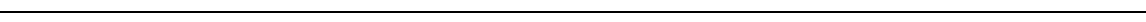
Fig. 4 Apical actin nucleated by formins contributes to centriole stability in mature ependymal cells. a Mature (P15) ependymal cell centrioles (labelled with FOP or Cep164; red) and formins (green and grey); note that all formins colocalise with the centriolar patch (red dashed lines); cell borders are outlined with dashed white lines. b – d Lateral wall explants from P15 mice treated for 12 h with DMSO or SMIFH2. b F-actin (phalloidin, grey) and centrioles (FOP, red) in mature ependymal cells from DMSO- or SMIFH2-treated explants. Cell borders and centriolar patches are outlined with dashed white and red lines, respectively. In control (DMSO-treated) explants, apical actin is enriched in the centriolar patch; formin inhibition prevents enrichment. Subapical actin staining is slightly affected by SMIFH2-treatment. c , d Ratio between mean phalloidin fl uorescence intensities in the centriolar patch (red dashed lines) and in the remaining cell surface (white minus red dashed lines) at the apical ( c ) and subapical ( d ) levels. Error bars represent the sem of: at the apical level, n = 96 cells for DMSO- and SMIFH2-treated explants; at the subapical level, n = 56 and 82 cells for DMSO- and SMIFH2-treated explants, respectively, from three independent experiments. P -values were determined by the Mann – Whitney test; * P = 0.0156; *** P ≤ 0.0001. Scale bars = 5 μ m. e Representative kymographs (200 ms) of motile cilia in P15 brain slices treated for 12 h with DMSO or SMIFH2 (formin inhibitor). The graph shows the cilia beating frequency (Hz); formin inhibition had no effect. Error bars represent the sem of n = 29, 48 cells for DMSO- and SMIFH2-treated explants from three independent experiments; P -values were determined with the Mann – Whitney test; ns, P > 0.05. f Representative images of Centrin2-GFP + centriolar patches. g Fold change in centriole number relative to DMSO-treated contralateral brain in lateral ventricles treated with SMIFH2, showing a reduction of the centriole number after SMIFH2-treatment; P -values were determined with the Mann – Whitney test. Error bars represent the sem of n = 1572 cells for DMSO- and 466 for SMIFH2-treated explants, from three independent experiments; *** P ≤ 0.0001. Scale bars = 5 μ